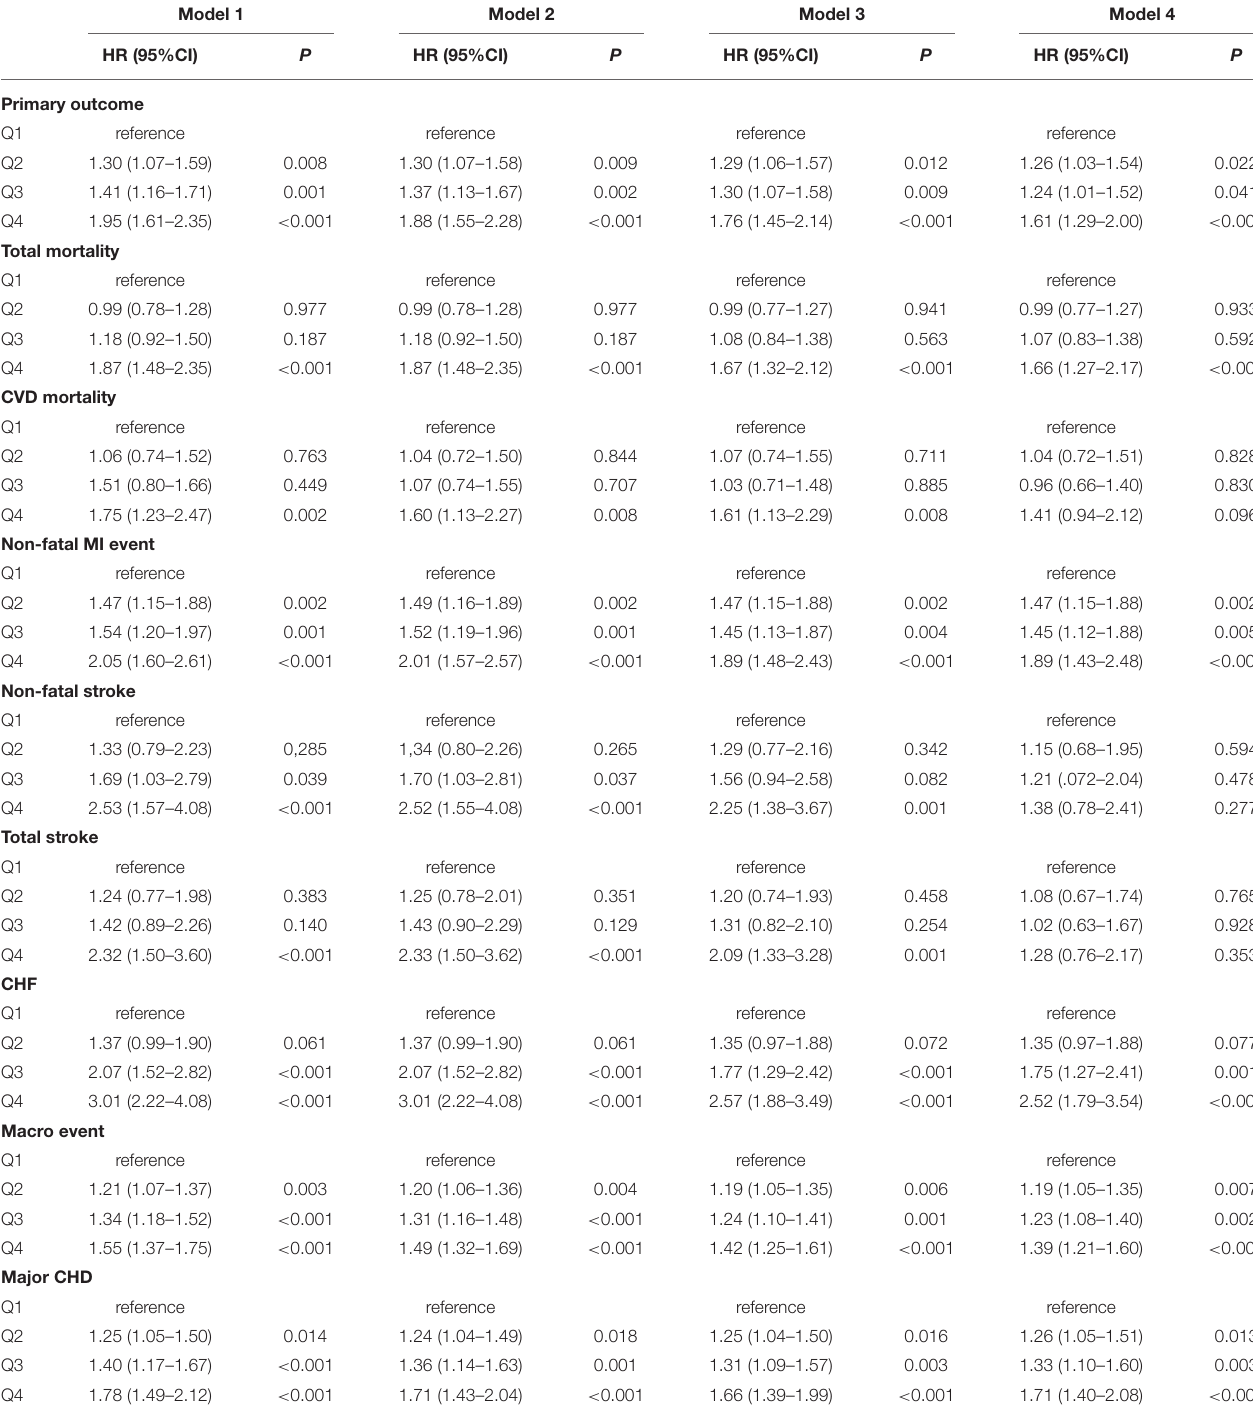
TABLE 3 | Visit-to-visit variability of HbA1C as a categorical variable and cardiovascular outcomes. Model